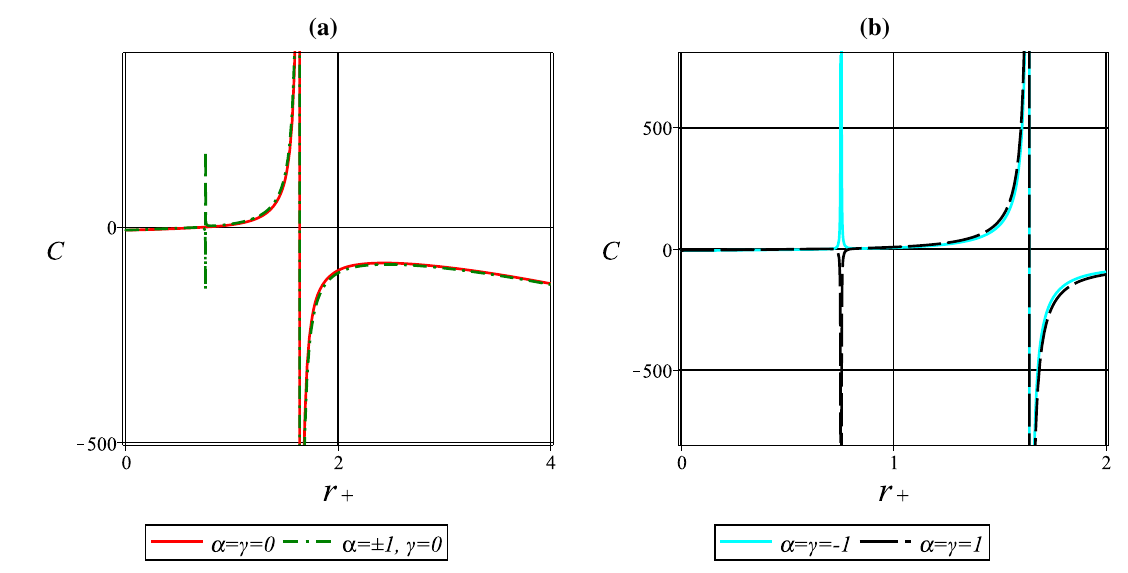
Fig. 13 Specific heat of KS solution in terms of the black hole horizon for ω = 1 and k =